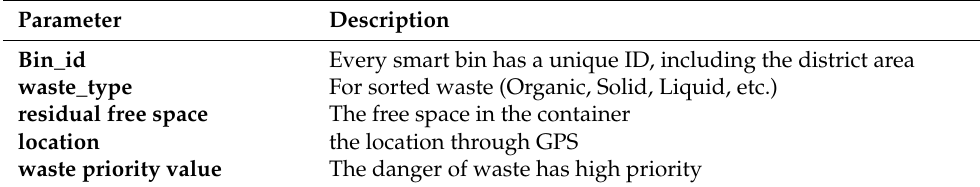
Table 2. Parameters of smart bin waste information.